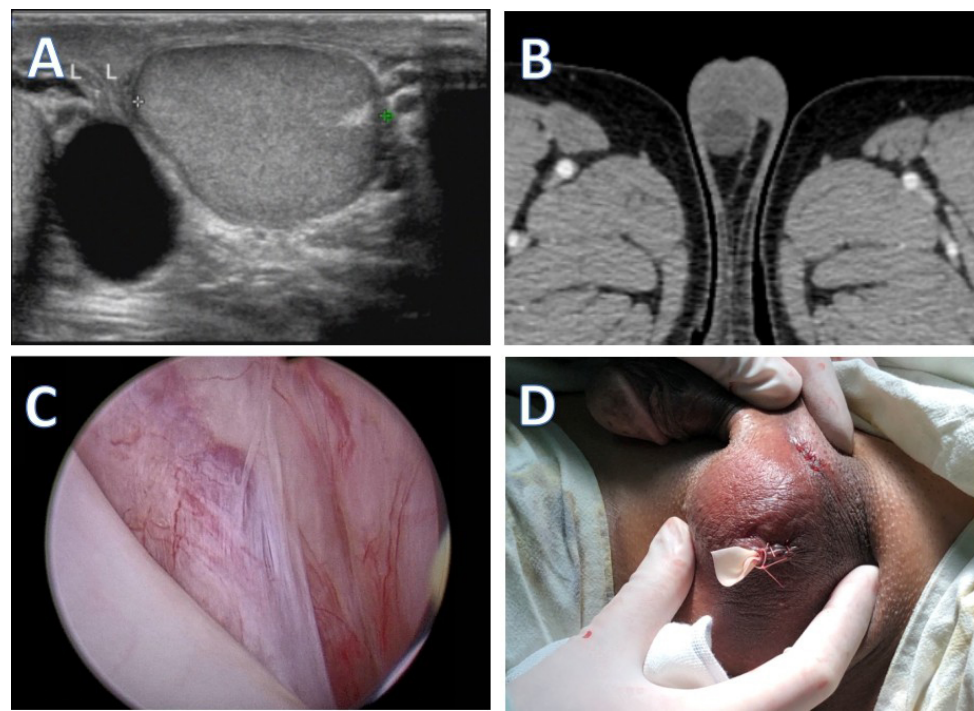
Fig. 3. Clinical features of patients with a scrotal wall mass. (A) Ultrasound image of case No. 6 indicates a 1.9-cm cyst located inside the scrotum that may have originated from the spermatic cord. (B) We further performed enhanced computed tomography for this patient, and the cyst was located posterior to the right testicle. (C) During the scrotoscopic exploration, no mass was observed in the cavity of the perididymis. We confirmed a mass located in the scrotal wall. (D) Postoperative incision of case No. 6 shows that two incisions were made on the right side of the scrotum (the upper incision was for the scrotoscope examination and the lower incision was for mass excision), and no scrotal edema occurred after